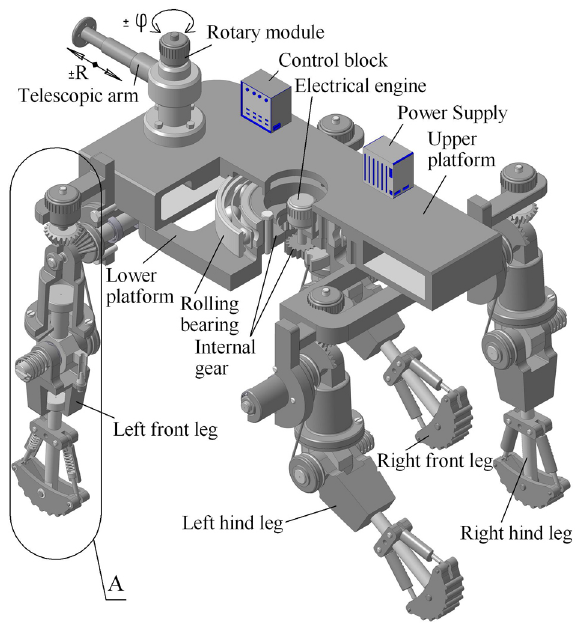
Figure 1. Anthropomorphic walking robot (3D model in quarter section) The robot's leg structures are the same (see Figure 2), and each of them contains a thigh, a lower leg, and a foot, which are kinematically connected to each